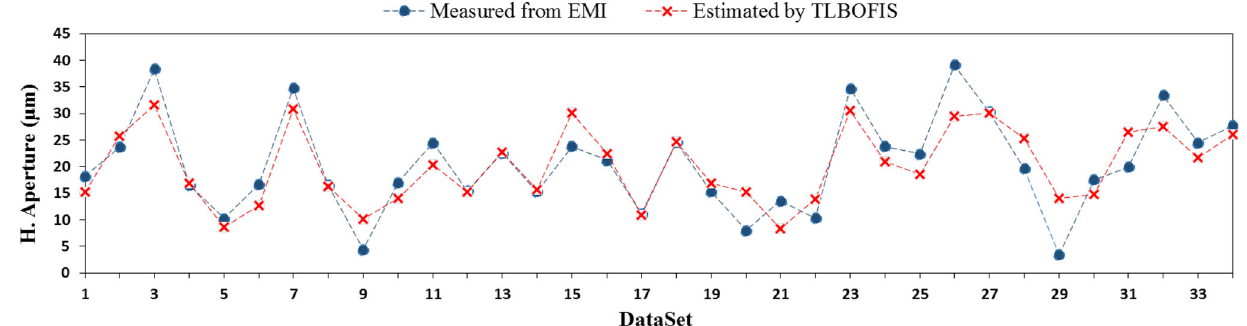
Fig. 8 A comparison between the measured hydraulic aperture and TLBOFIS predicted values for fractures in the test